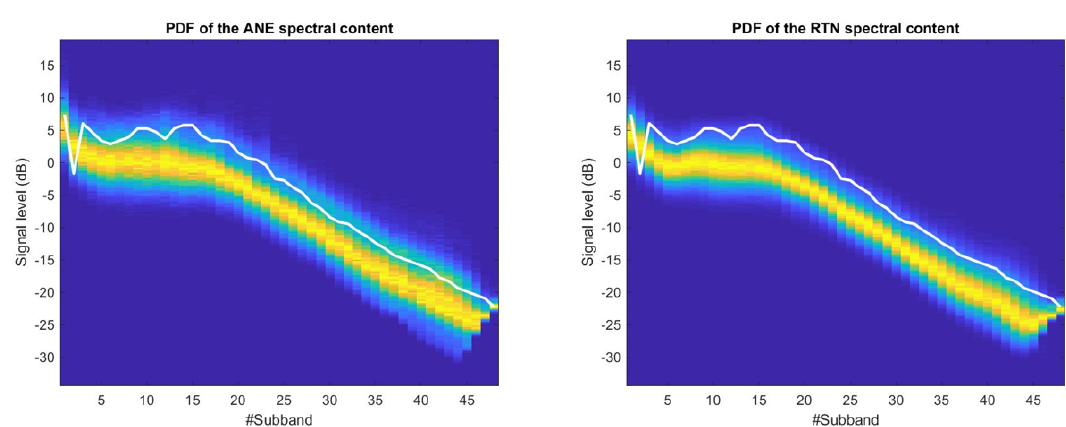
Figure 4. 2D-PDF of the ANE ( left ) and the RTN ( right ) of the suburban dataset. The frequency subband index i corresponding to the MFS is labelled in the x-axis (the reader can find the corresponding frequency in Table 1), while the corresponding logarithmic signal level at each subband is depicted in the y-axis in dBs. The Figures colormap is blue for lower probabilities while tends to warm colors (with the maximum in red) for higher probabilities. The solid white line represents the optimum decision threshold for the one-band linear discriminant classifier at each frequency